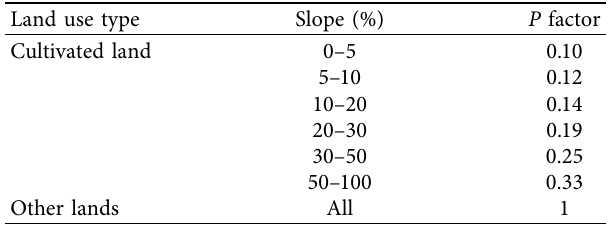
Table 5: P factor values for watershed conservation